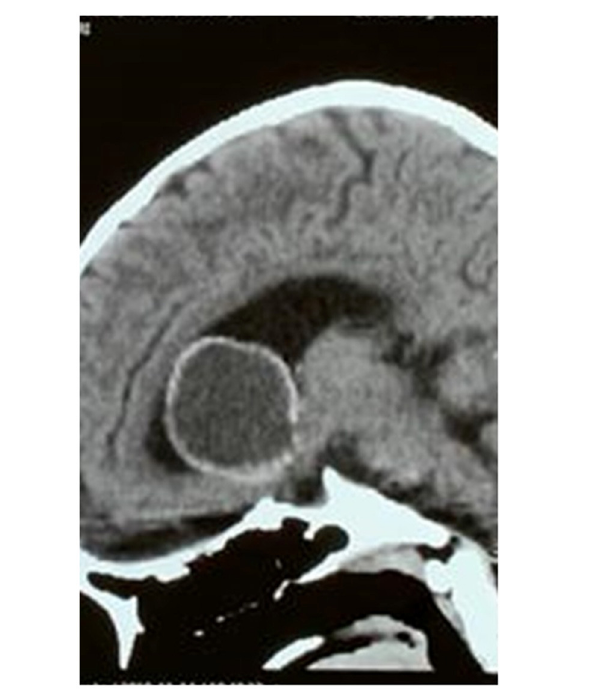
FIGURE 3 | Sagittal section CT scan of a patient with a cystic intraventricular craniopharyngioma showing peripheral calcification, and a bulge in the floor of the third ventricle.